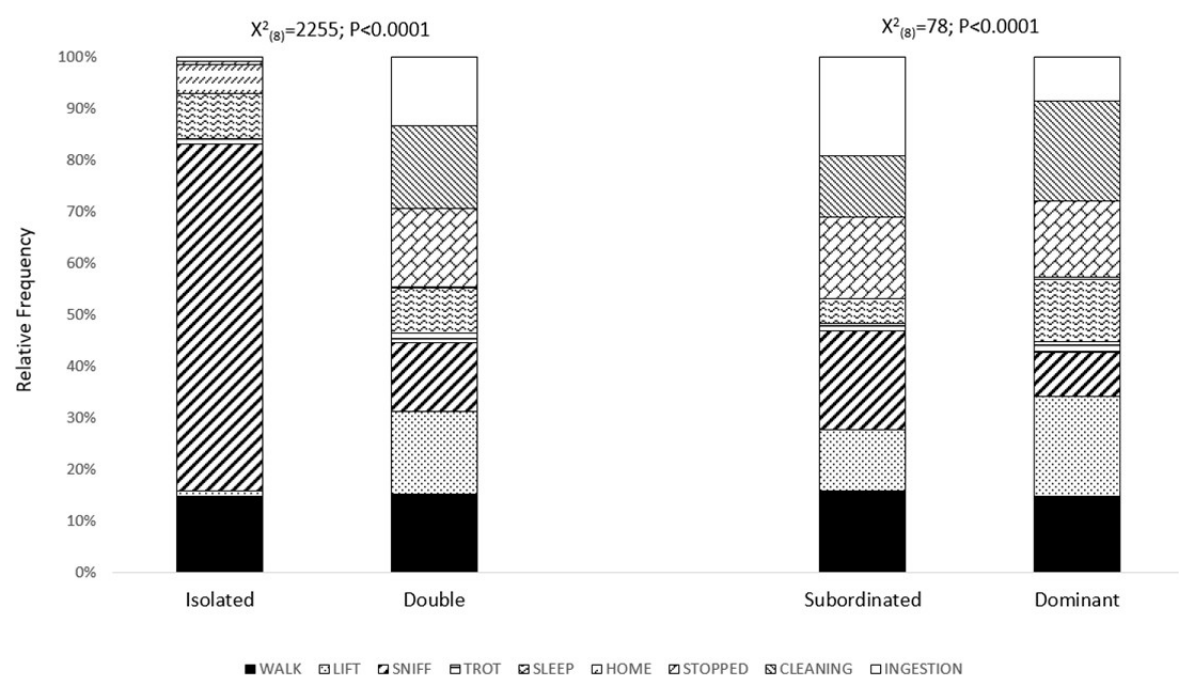
Figure 4. The relative frequency of motor patterns relating to the “Object Interaction category”. The absolute frequencies were compared between isolated, double animals, between subordinate, and dominant animals using the chi-square test, with significantly higher values (P < 0.05) followed by an asterisk